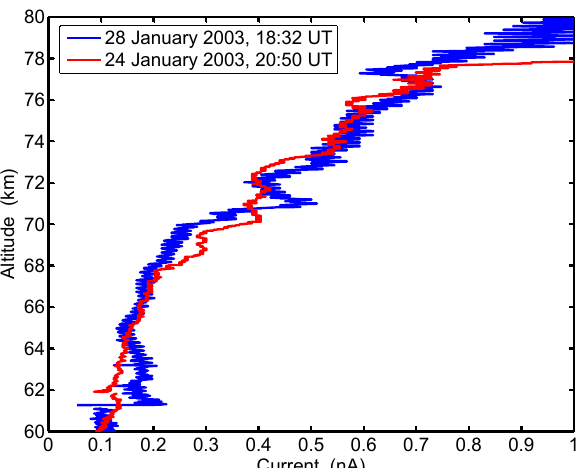
Fig. 6. Negative current measurements, indicative of relative nega- tive charge densities, obtained by Langmuir probes on instrumented rocket payloads launched at 20:50 UT on 24 January 2003 and at 18:32 UT on 28 January